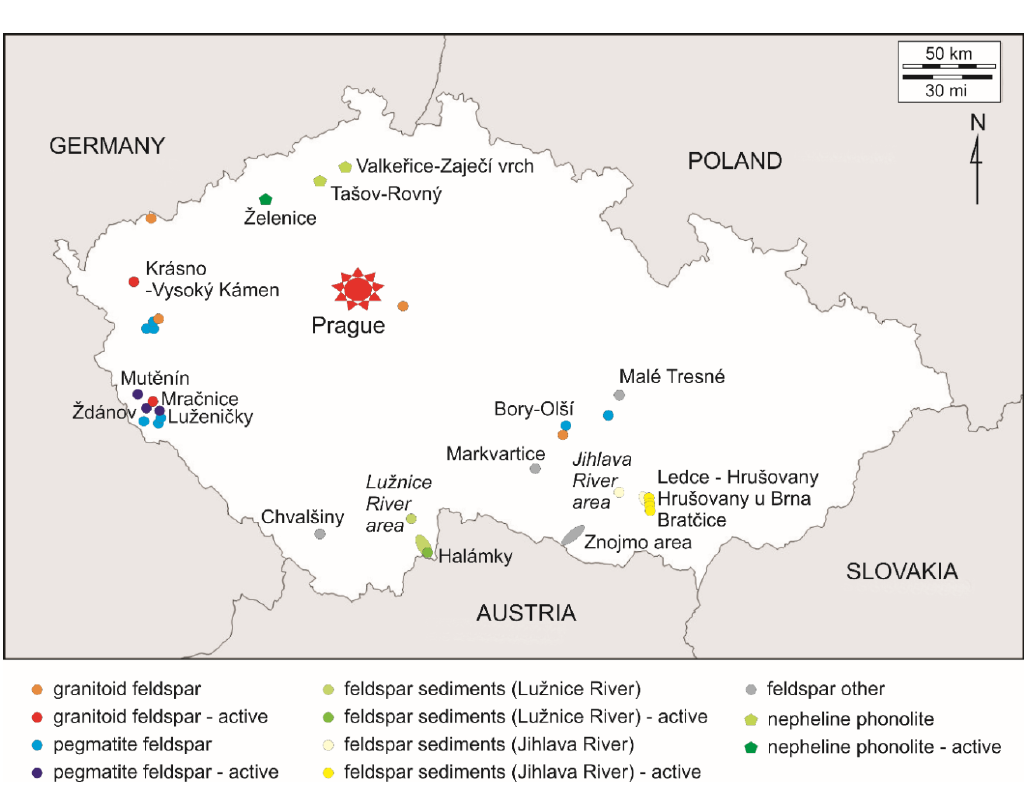
Figure 2. Simplified geological map the Czech Republic [38]. To help better understanding the production cycle of feldspar in the Czech Republic described in detail later, brief characteristics of quarrying techniques and processing in as follows: technology